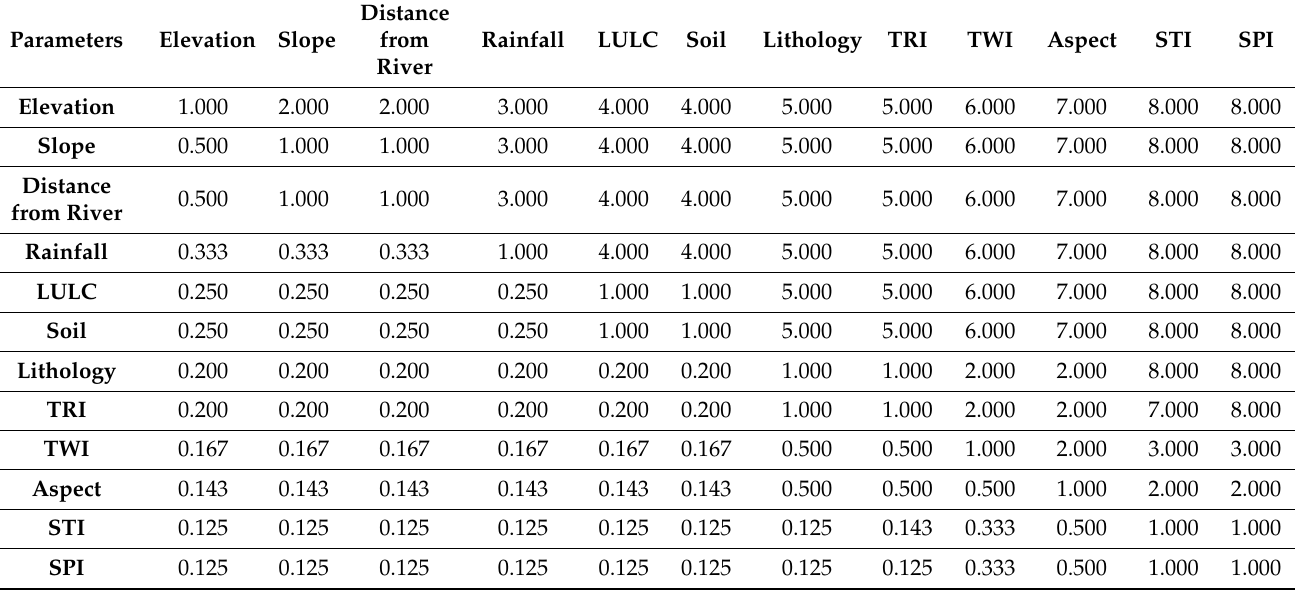
Table 2. Each parameter’s comparison matrix and relative score.